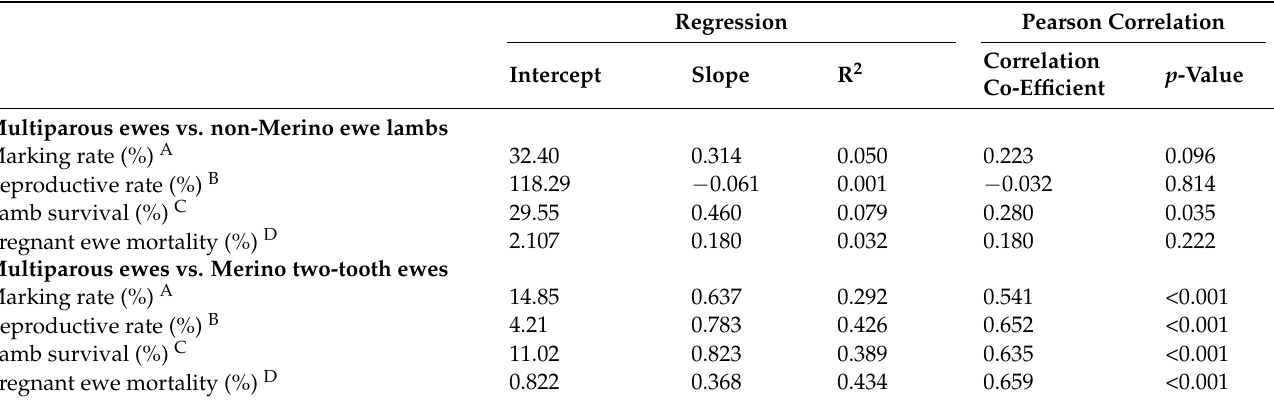
Table 5. Linear regression and bivariate Pearson correlation (two-tailed) between reproductive traits in maiden ewes and corresponding measure for multiparous counterparts.